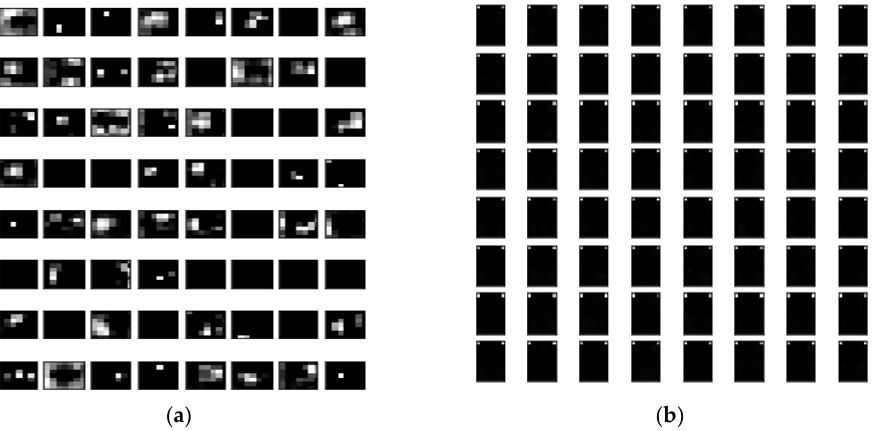
Figure 13. Visualized feature maps of the last layer in the ( a ) VGG16 and ( b ) EfficientNetV2L net- works.